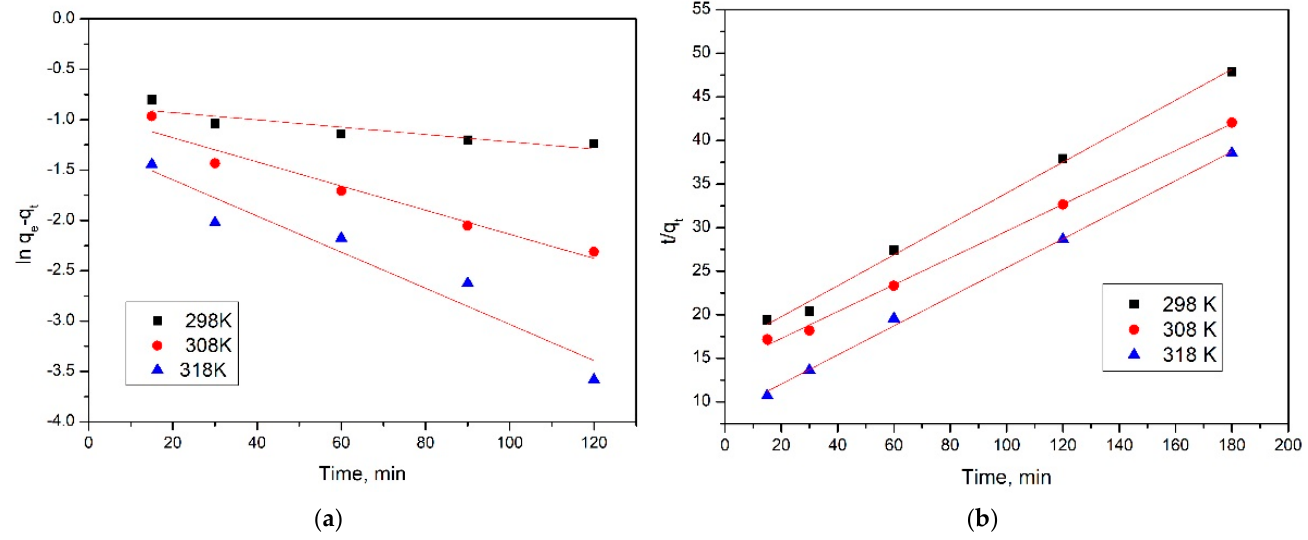
Figure 11. Pseudo-first order ( a ) and pseudo-second order ( b ) isotherms. Table 3. Kinetic parameters obtained from data modelling.